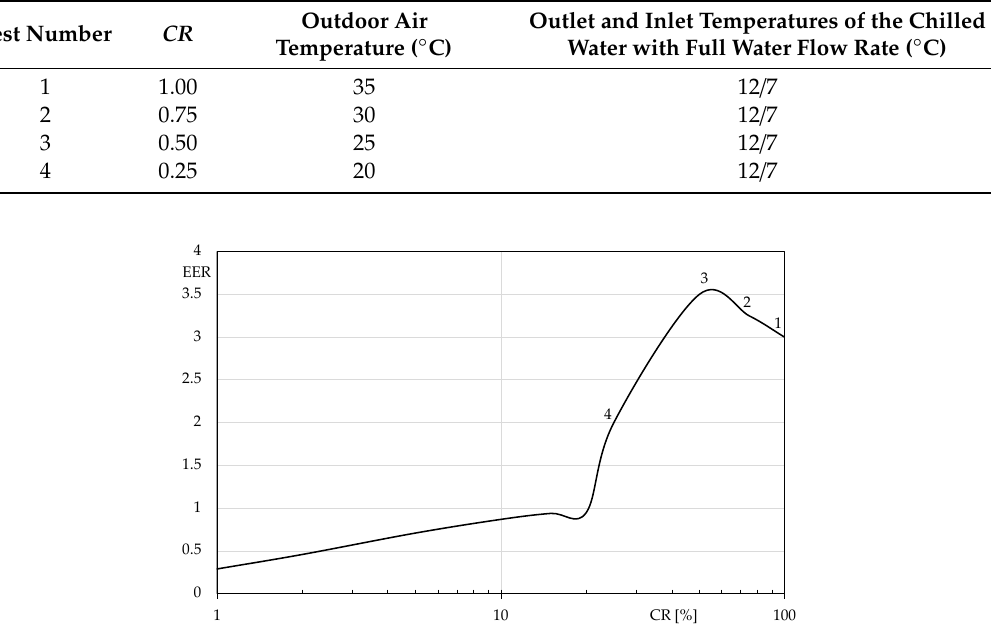
Figure 1. Example of the EER trend in the function of the values listed in Table 1.